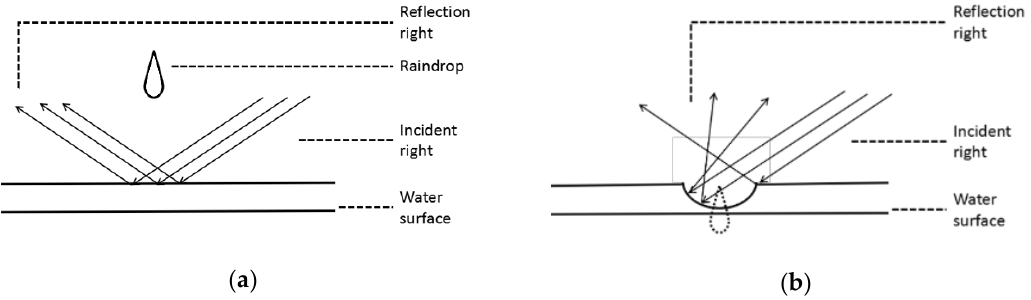
Figure 4. Raindrops landing on the water surface: before ( a ) and after ( b ) the rain drop.